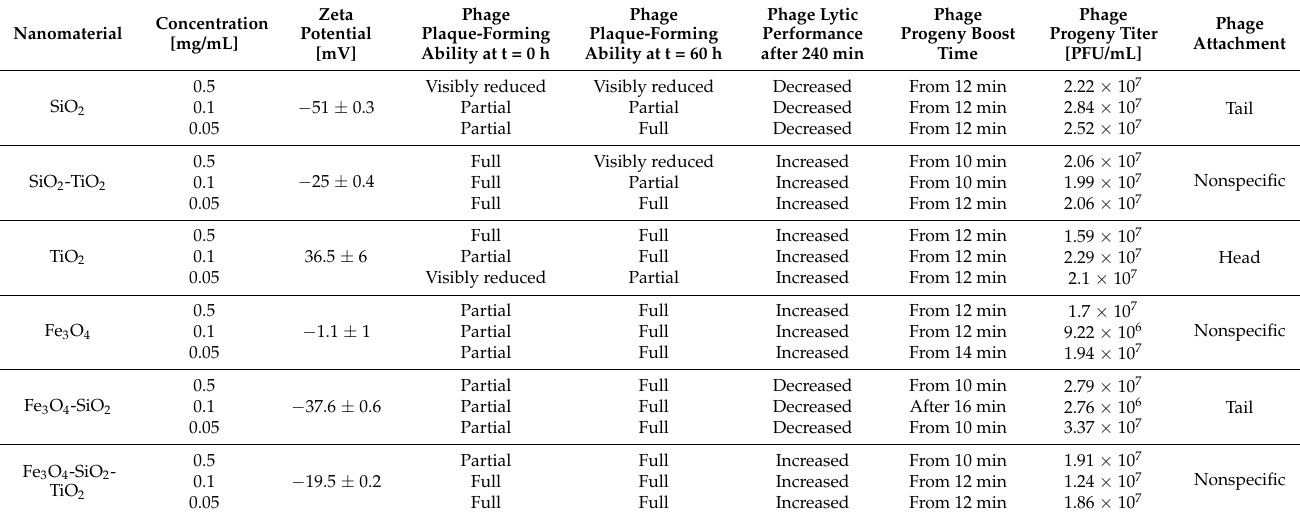
Table 2. Key concentrated results of the present study, based on all of the obtained results.